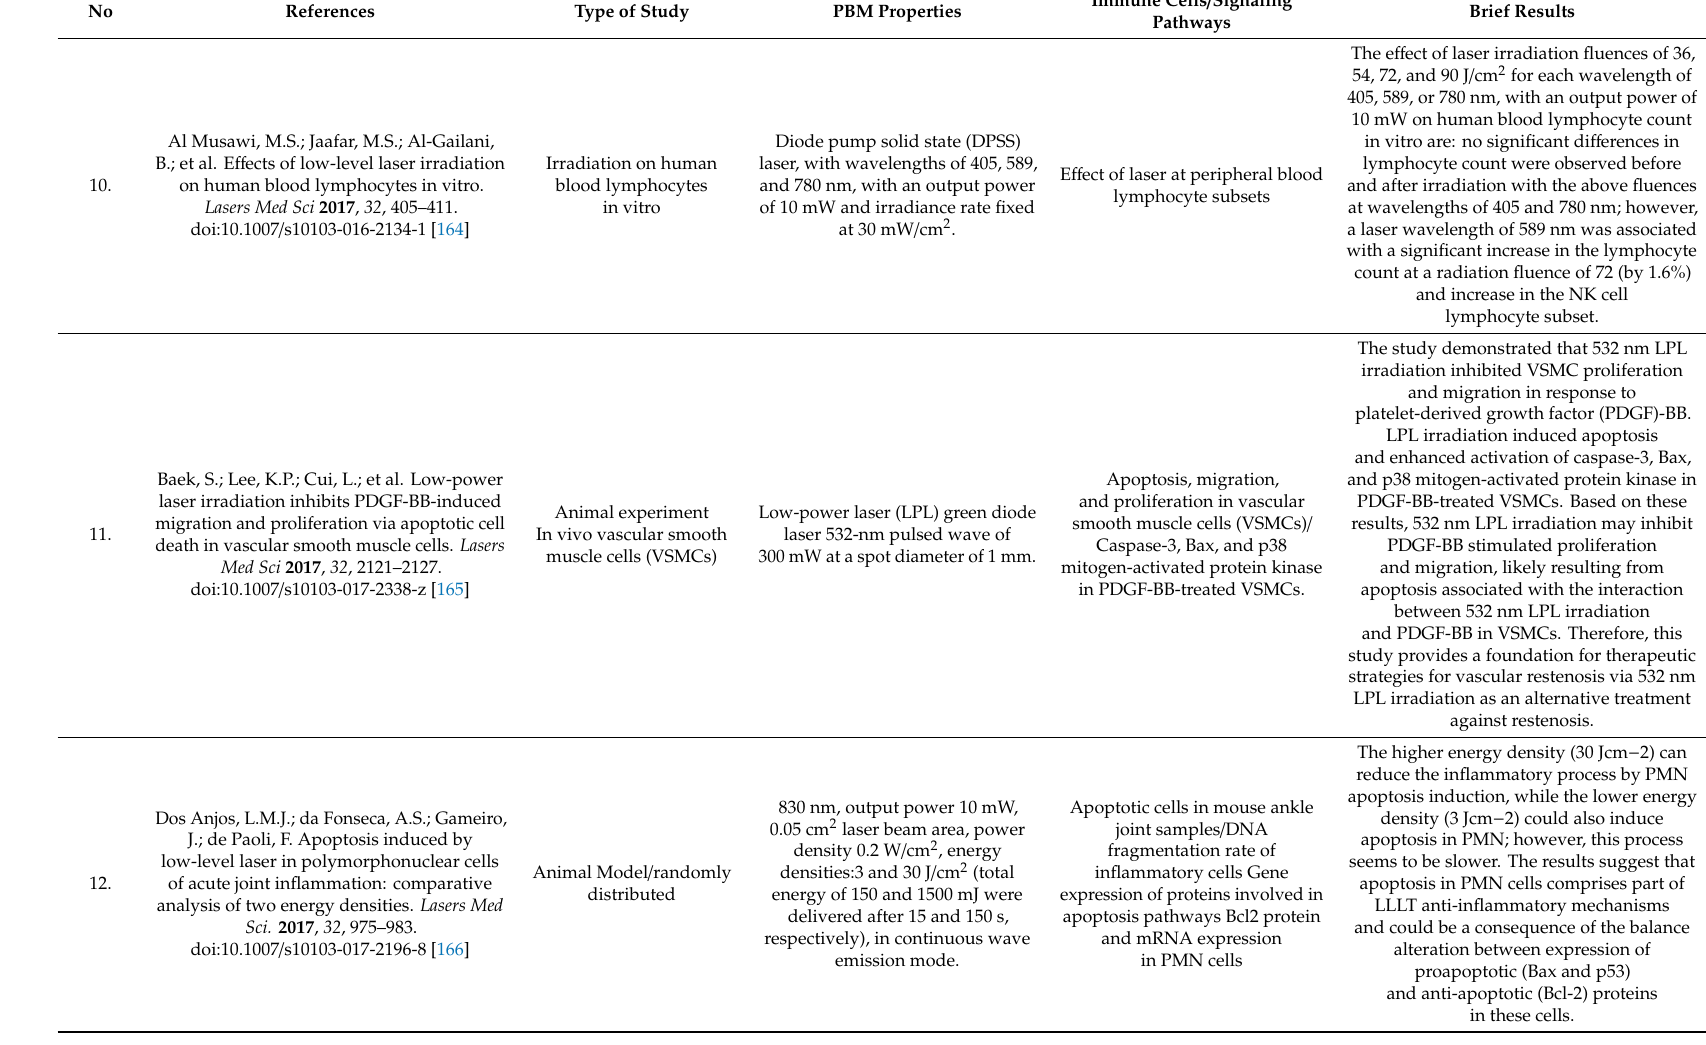
The e ff ect of laser irradiation fluences of 36, 54, 72, and 90 J / cm 2 for each wavelength